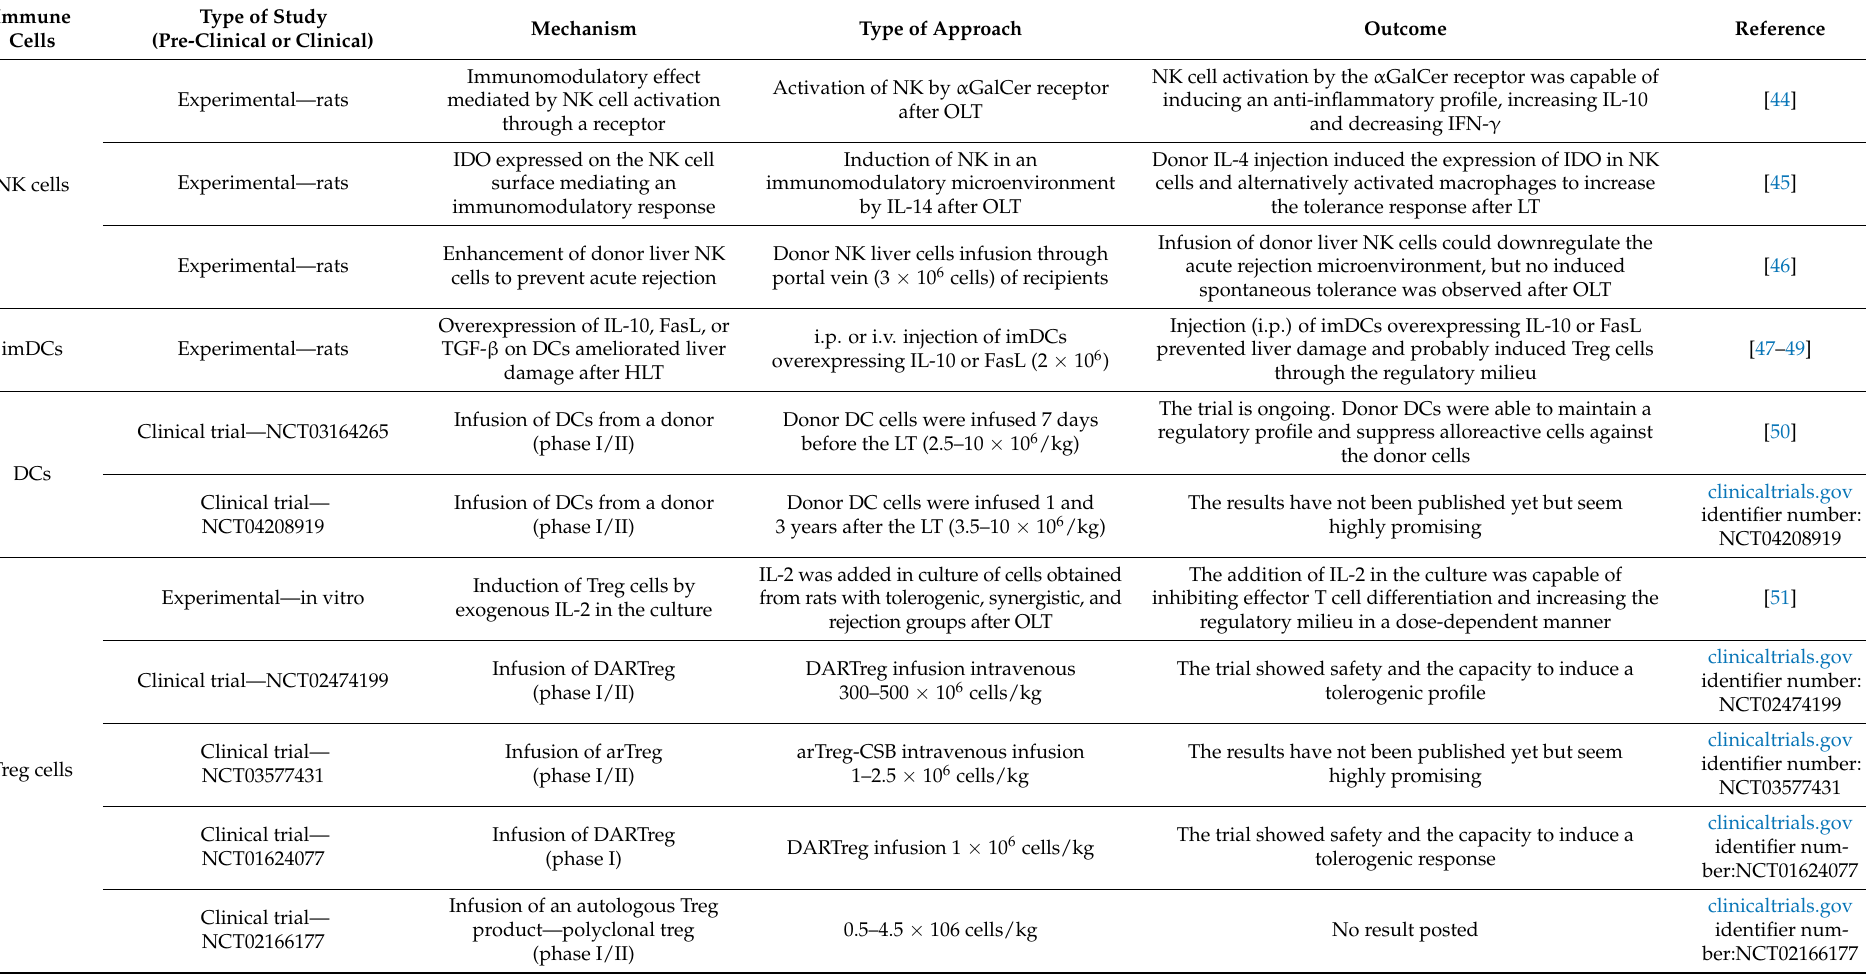
Table 2. Immune cells and the mechanism of tolerance after liver